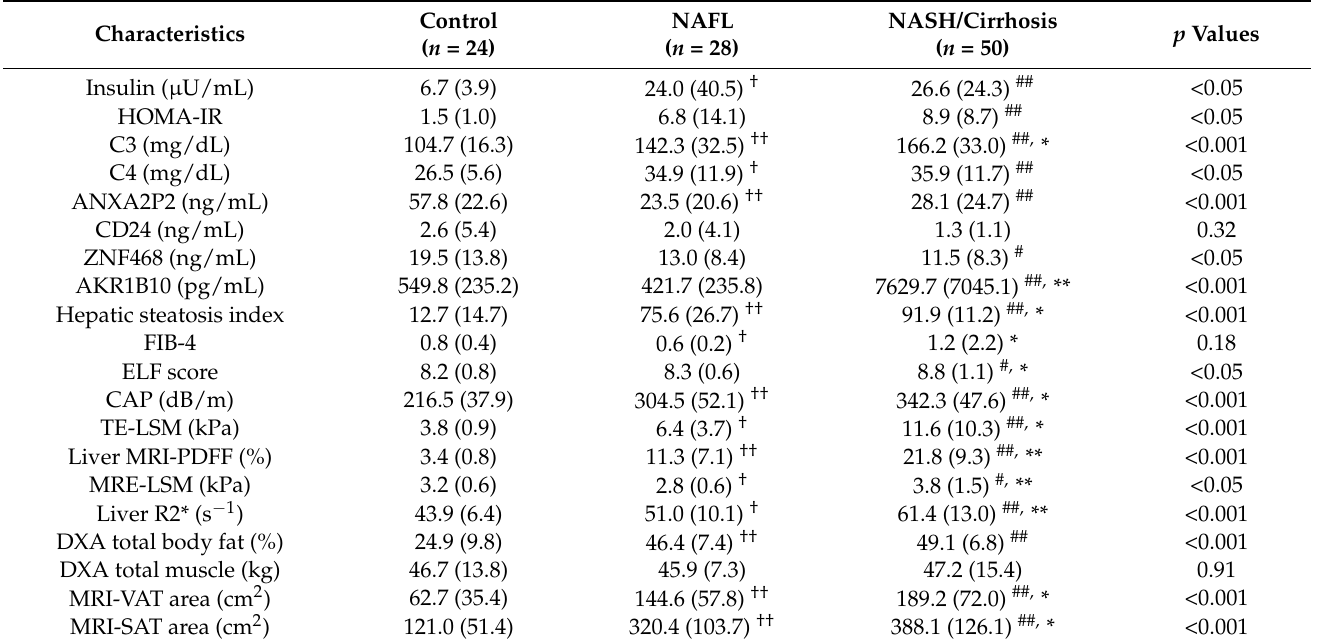
(Table 2). We also calculated AUROCs for other clinically available markers: C3 as a